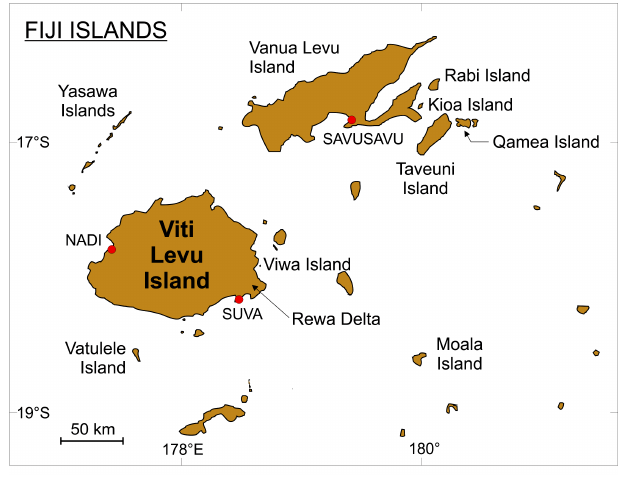
Fig. 1 . Map of the Fiji Islands showing the locations of study sites (see Table 1 for more detailed